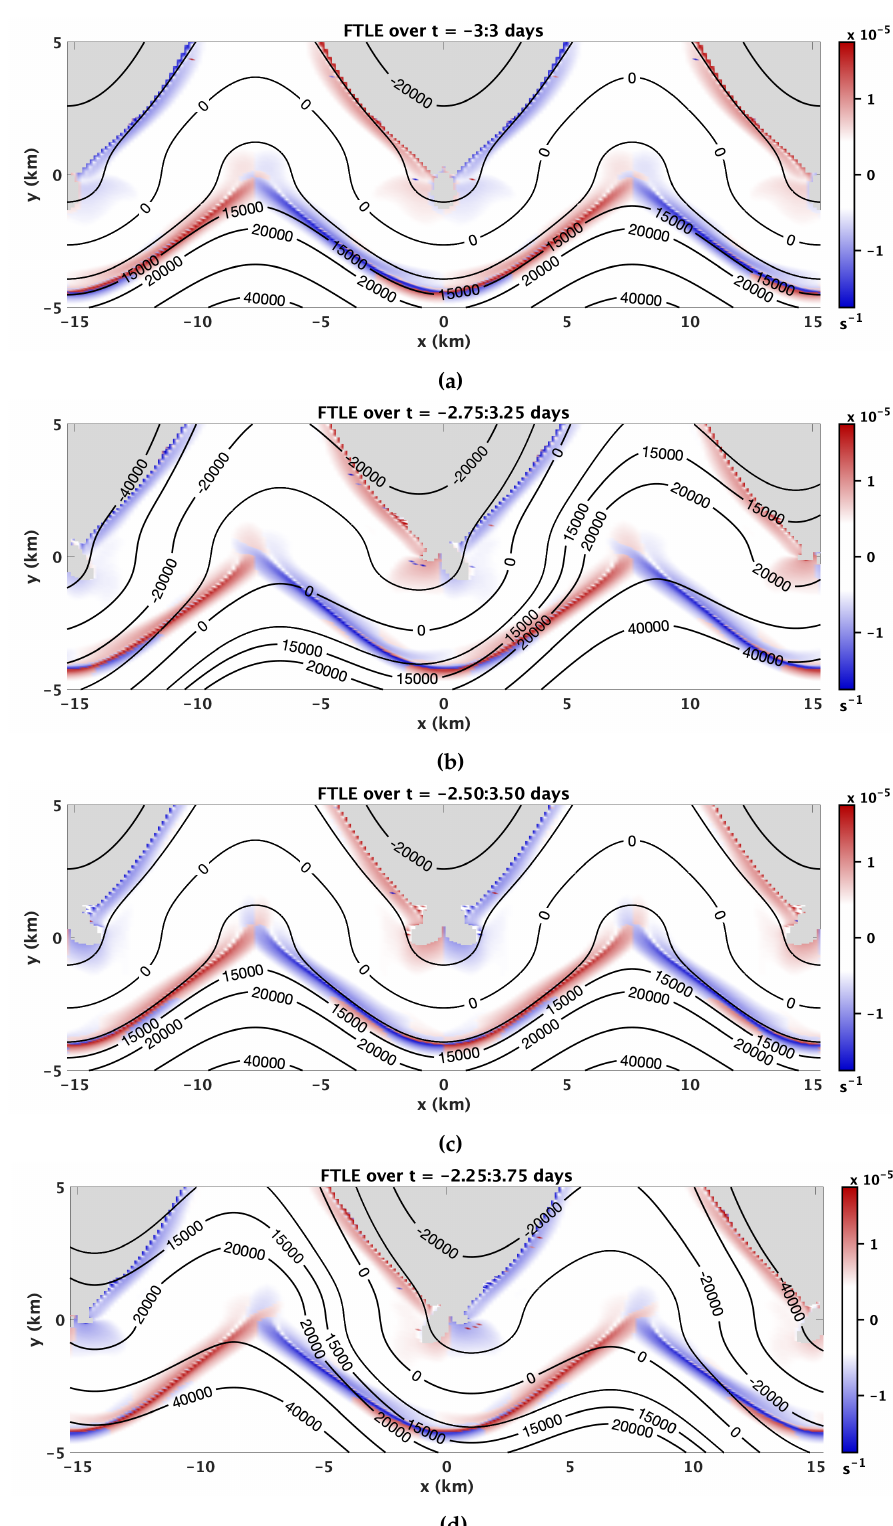
Figure 3. Finite-time Lyapunov exponent (FTLE) field for the base case parameters in Table 1, evaluated over the time interval from three days forward and backward, centered at ( a ) t = 0, ( b ) t = 0.25 days, ( c ) t = 0.5 days, and ( d ) t = 0.75 days. Backward-time FTLEs are shown at the blue end of the colormap, while forward-time FTLEs are displayed in red. Black contours show the volume-transport streamfunction at the center time. Grey shading indicates a lack of data due to boundary